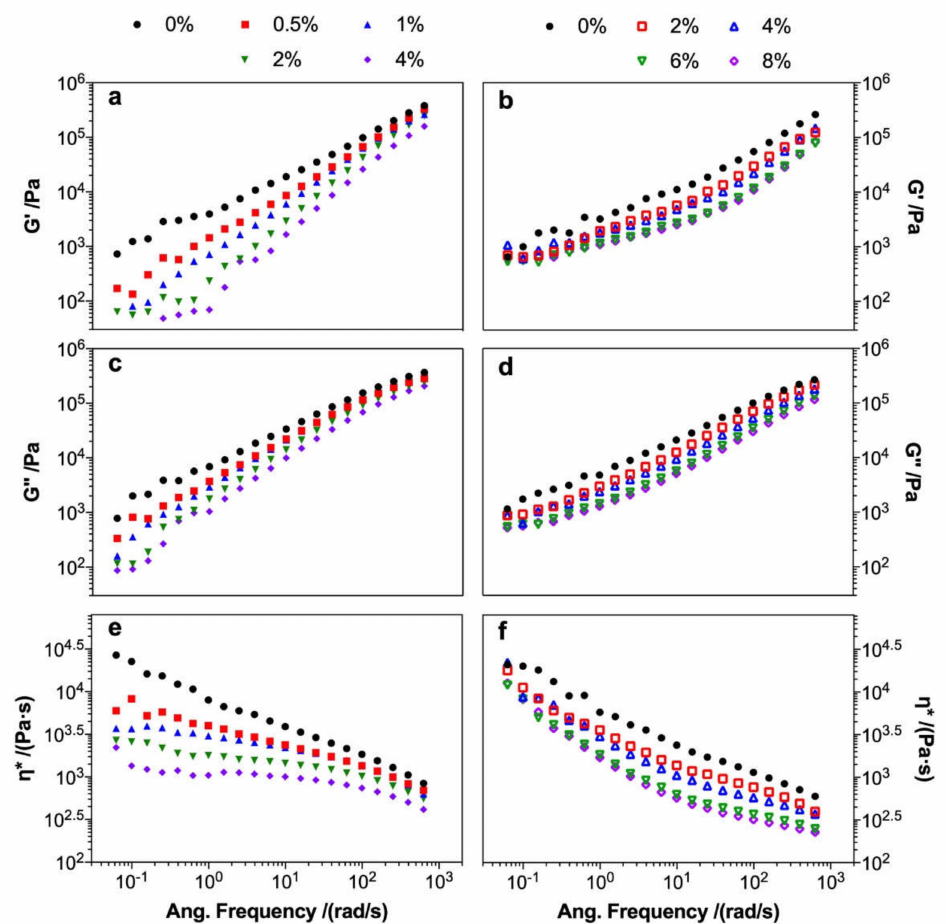
Figure 6. Rheological properties of the MA- ( a , c , e ) and KH550- ( b , d , f ) modified poplar fiber / PLA composites: ( a , b ) storage modulus, ( c , d ) loss modulus, and ( e , f ) complex